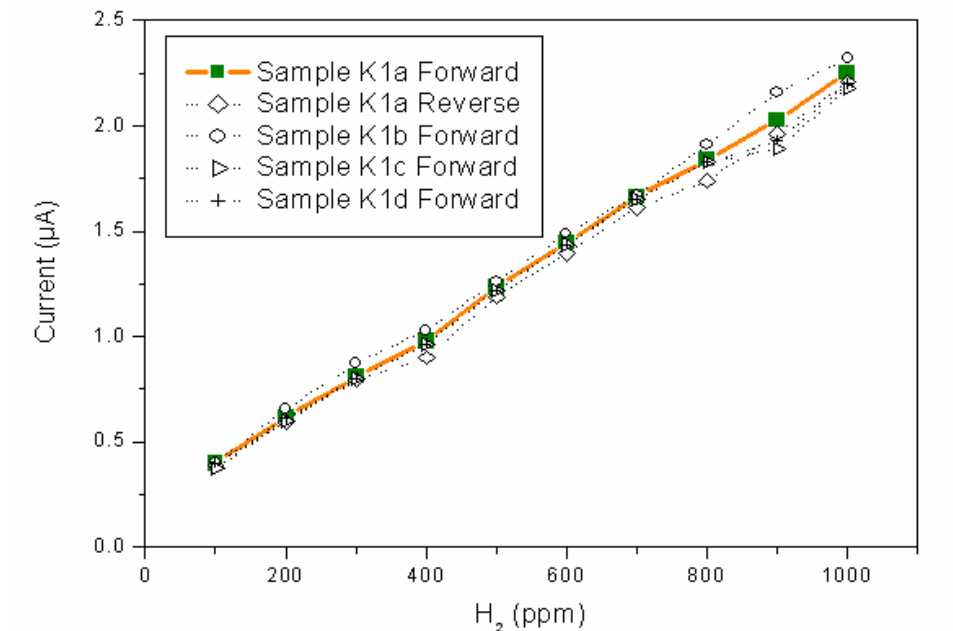
Figure 9. Linear relation for 0.01 M KBH (sample K1) concentration over a wide range of hydrogen 4 concentration (100-1000 ppm) and a sensing area of 2 cm 2 . The dotted lines are results from calibrations with different